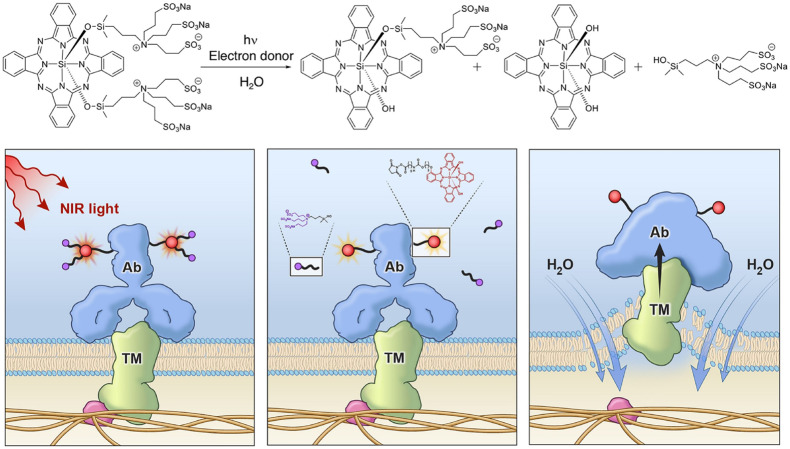
A schematic for the chemical reaction of NIR-PIT (top) and the mechanisms underlying the disruption of tumor cells (Liang et al., 2018). Reproduced with permission from reference Liang et al. (2018).